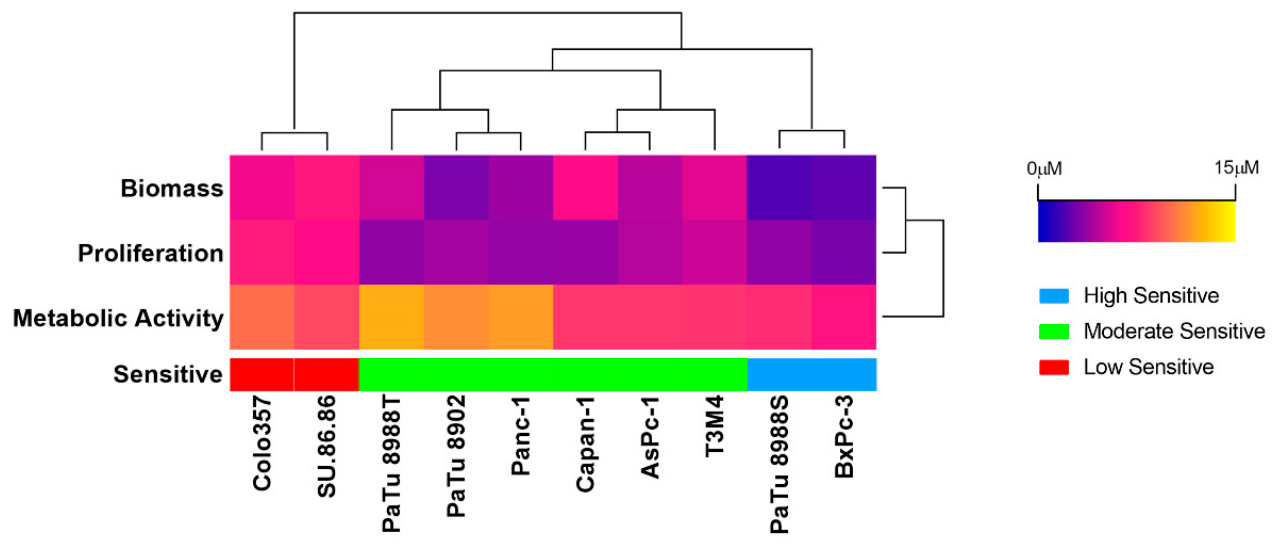
Figure 1. IC50 values when assessing proliferation, metabolic activity, and cell biomass after 72 h MK-2206 exposure in ten PDAC cell lines, as well as the classification of these cell lines by k-means++ (unsupervised machine learning algorithm) into low (red), moderate (green), and high (blue) groups. These IC50 values were clustered by unsupervised machine learning into three sensitivity groups: low (Colo357 and SU.86.86), moderate (PaTu8988T, PaTu8902, Panc-1, Capan-1, AsPc-1, and T3M4), and high (PaTu8988S and BxPc-3) sensitivity groups (Figures 1 and S2). When treating the cell lines with the Pan-PI3K inhibitor Buparlisib for 72 h, it signifi- cantly inhibited cell proliferation, metabolic activity, and cell biomass at a concentration of 0.5 µ M (Supplementary Figure S3 and Supplementary Table S3). In the three viability assays, Buparlisib demonstrated a similarly efficient inhibition of cell proliferation and metabolic activity. The IC50 values ranged from 0.4741 µ M to 2.469 µ M (proliferation), 0.7471 µ M to 4.098 µ M (metabolic activity), and 0.5916 µ M to 2.419 µ M (biomass) (Figures 2 and S4 and Supplementary Table